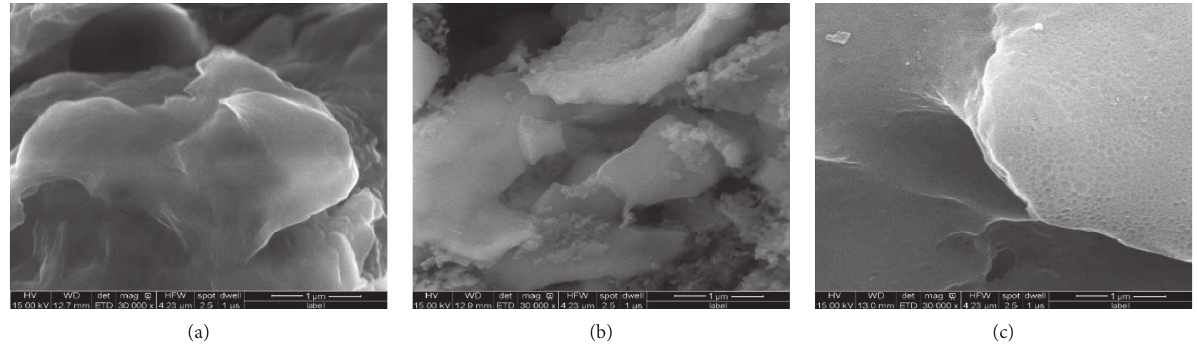
Figure 5: SEM images of (a) carbonized pomelo peel, (b) carbonized pomelo peel, and (c) PPAC.